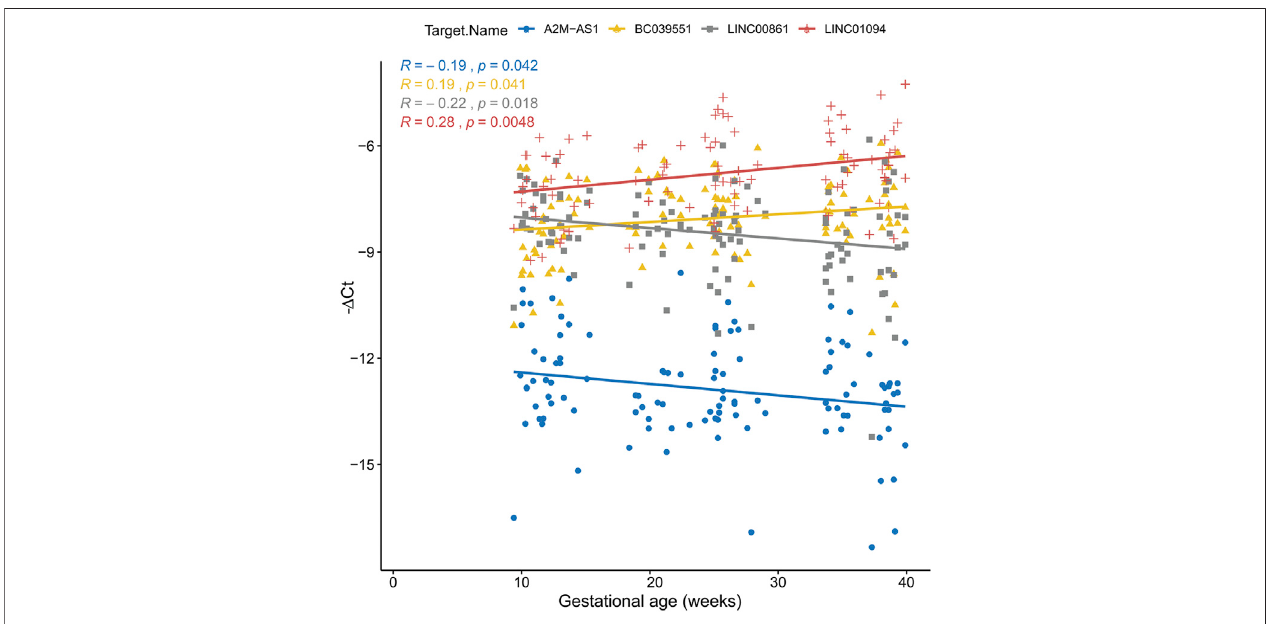
FIGURE 3 | Non-coding RNA changes as a function of gestational age. The fi gure shows the mean − Δ Ct (over three replicate measurements) in each of the 116 samples as a function of gestational age. Lines represent linear mixed-effects models fi t of the data.